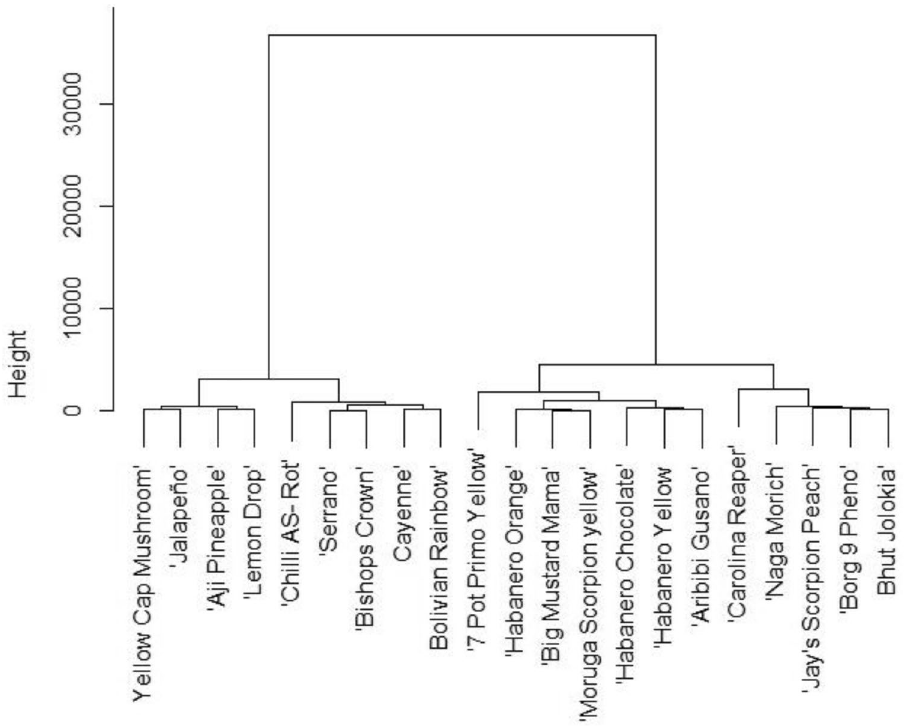
Figure 3. Clustering of chili cultivars based on total capsaicinoid